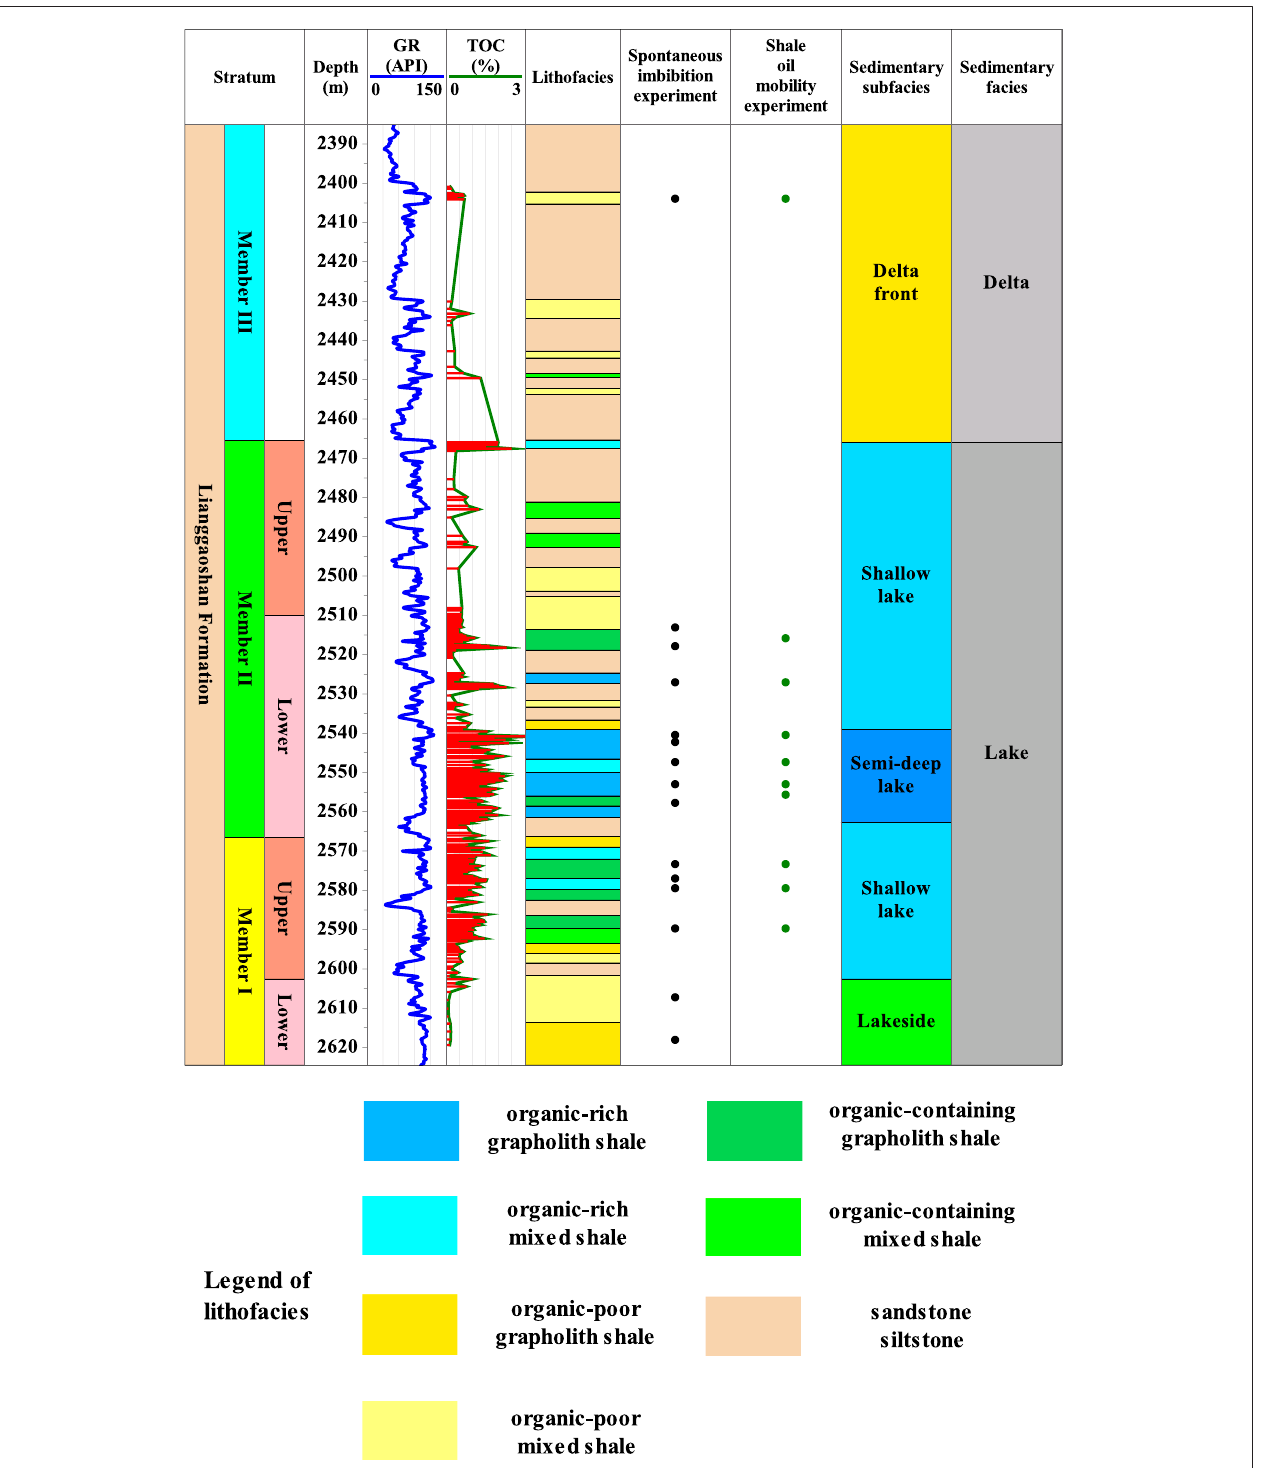
FIGURE 2 | The comprehensive stratigraphic column diagram of the Middle Jurassic Lianggaoshan Formation in the TY1 well. Modi fi ed from references (Liu W. et al., 2021; Wei et al., 2021).